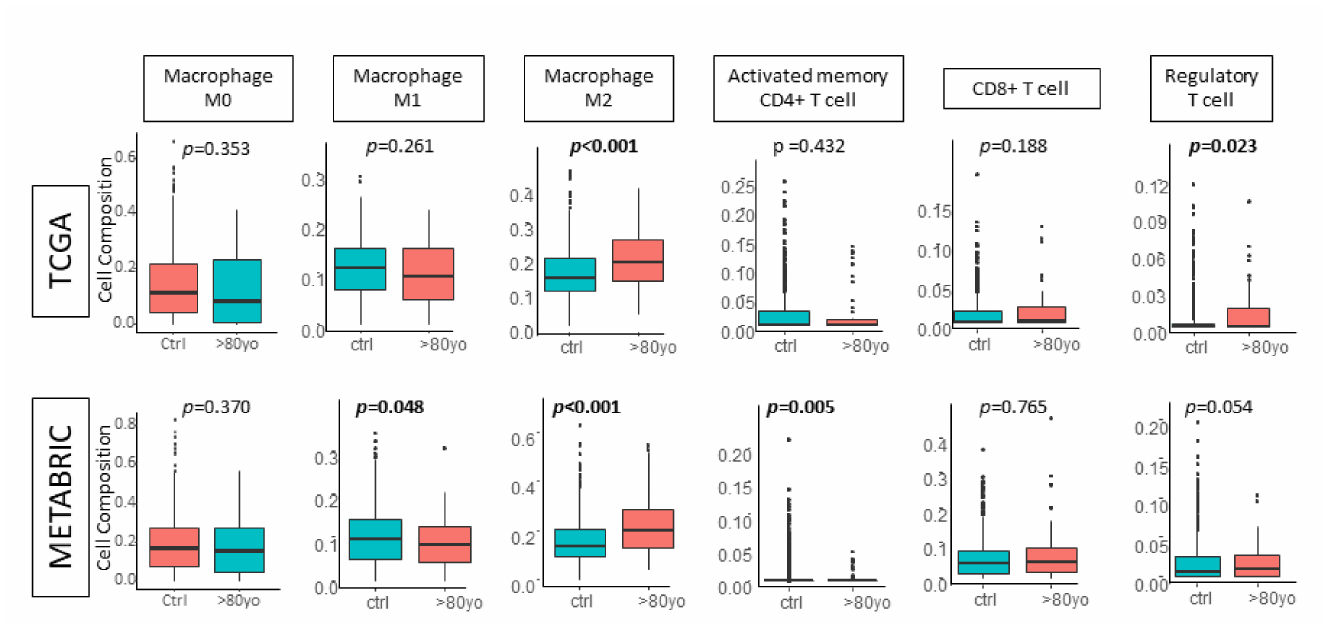
Figure 5. The CIBERSORT algorithm in the TCGA and the METABRIC cohorts. Boxplots comparing the control group and the octogenarian group by macrophage M0, macrophage M1, macrophage M2, activated memory CD4+ T cell, CD8+ T cell, and regulatory T